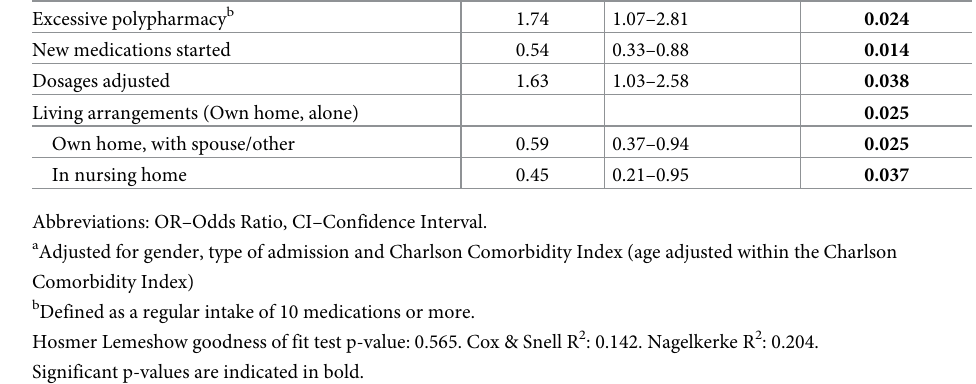
Abbreviations: OR–Odds Ratio, CI–Confidence Interval. a Adjusted for gender, type of admission and Charlson Comorbidity Index (age adjusted within the